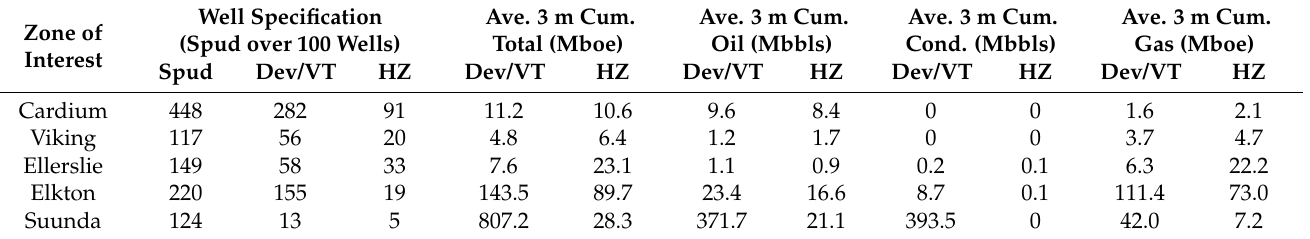
Table 1. Total spuds and average 3 months cumulative production of the study area (McKenzie,